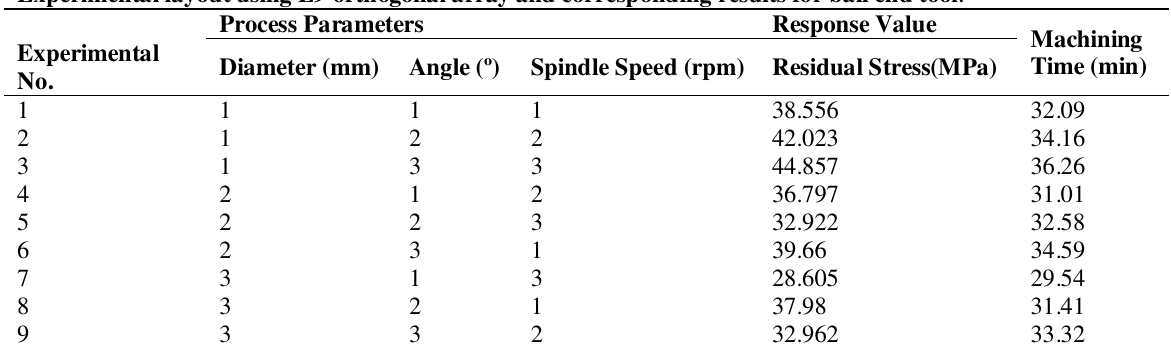
Experimental layout using L9 orthogonal array and corresponding results for ball end tool .